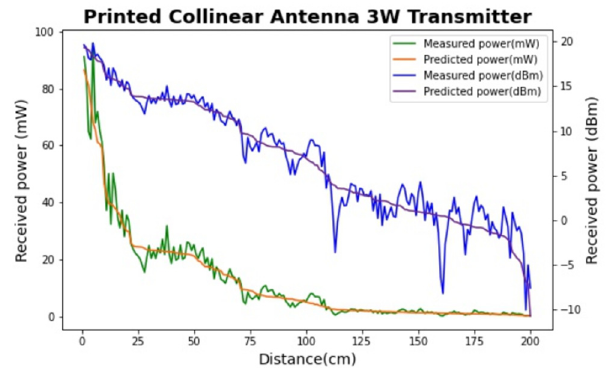
Figure 9. RF harvesting measurement data by the distance of collinear